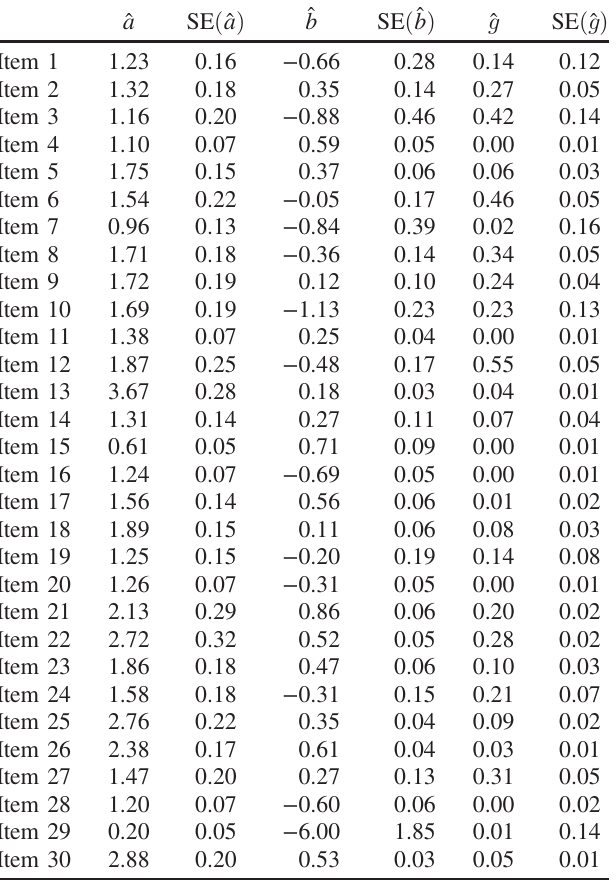
TABLE III. The results of the estimation for the item param- eters of the FCI based on the 3PL model ( N ¼ 2712 ). The estimates and the standard errors (SEs) for the item parameters are shown.